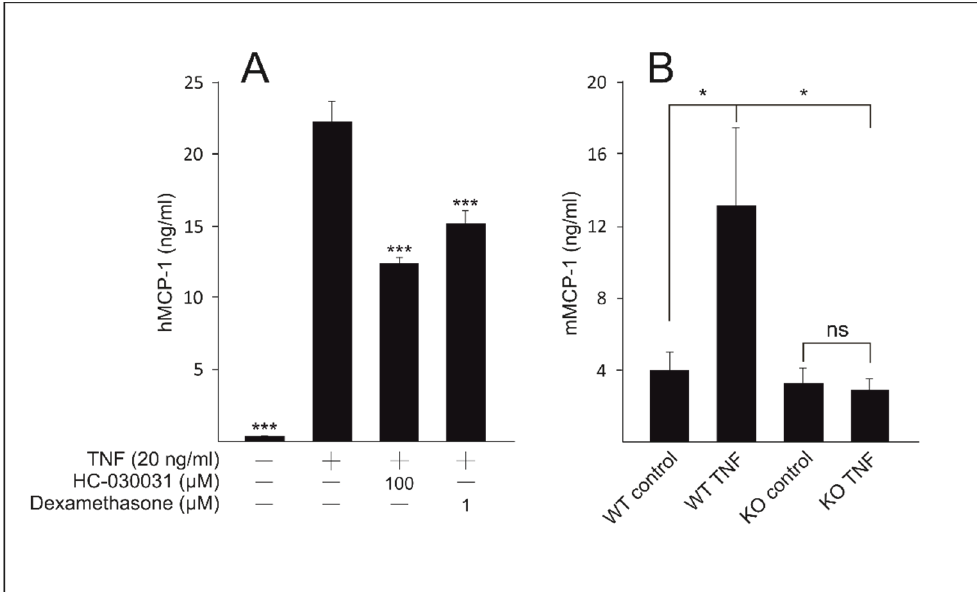
Figure 4. Transient receptor potential ankyrin 1 (TRPA1) mediates tumor necrosis factor (TNF)-induced production of monocyte chemoattractant protein 1 (MCP-1). ( A ) HaCaT cells were treated with the TRPA1 antagonist HC-030031 (100 µM) or the glucocorticoid dexamethasone (1 µM) and stimulated with TNF (20 ng/mL) for 24 h. ( B ) Skin samples from wild type (WT) and TRPA1 deficient (knockout, KO) mice were stimulated with TNF (20 ng/mL) for 21 h. MCP-1 concentrations in the culture medium samples were measured by enzyme-linked immunosorbent assay (ELISA). Results are expressed as mean + SEM, n = 4 ( A ) and n = 4–6 ( B ). Statistical significance was calculated against samples stimulated with TNF only using one-way ANOVA with Bonferroni’s post-test ( A ) or in (B) using repeated measures two-way ANOVA with Bonferroni’s post-test. * = p < 0.05, *** = p < 0.001.